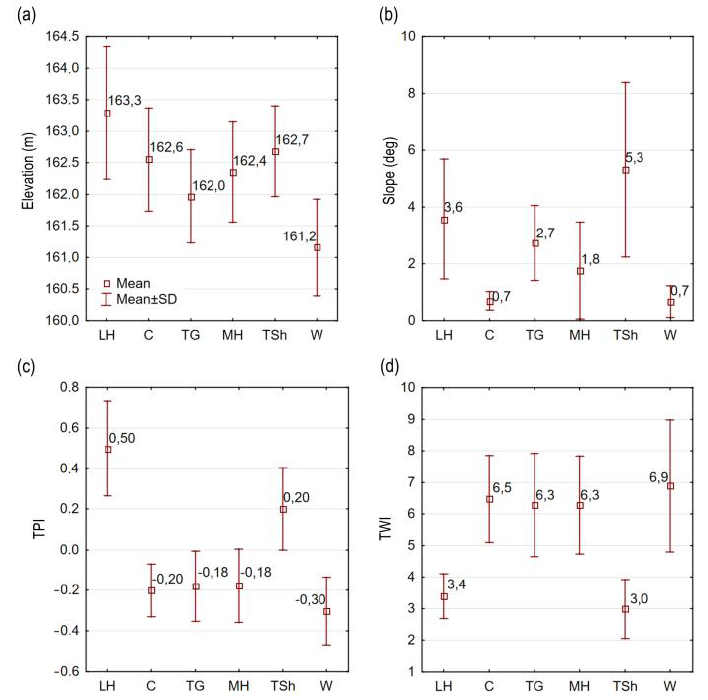
Figure 5. Means and standard deviations (SD) of morphometric variable values for training sample data ( a )—elevation, ( b )—slope, ( c )—topographic position index, and ( d )—topographic wetness index.